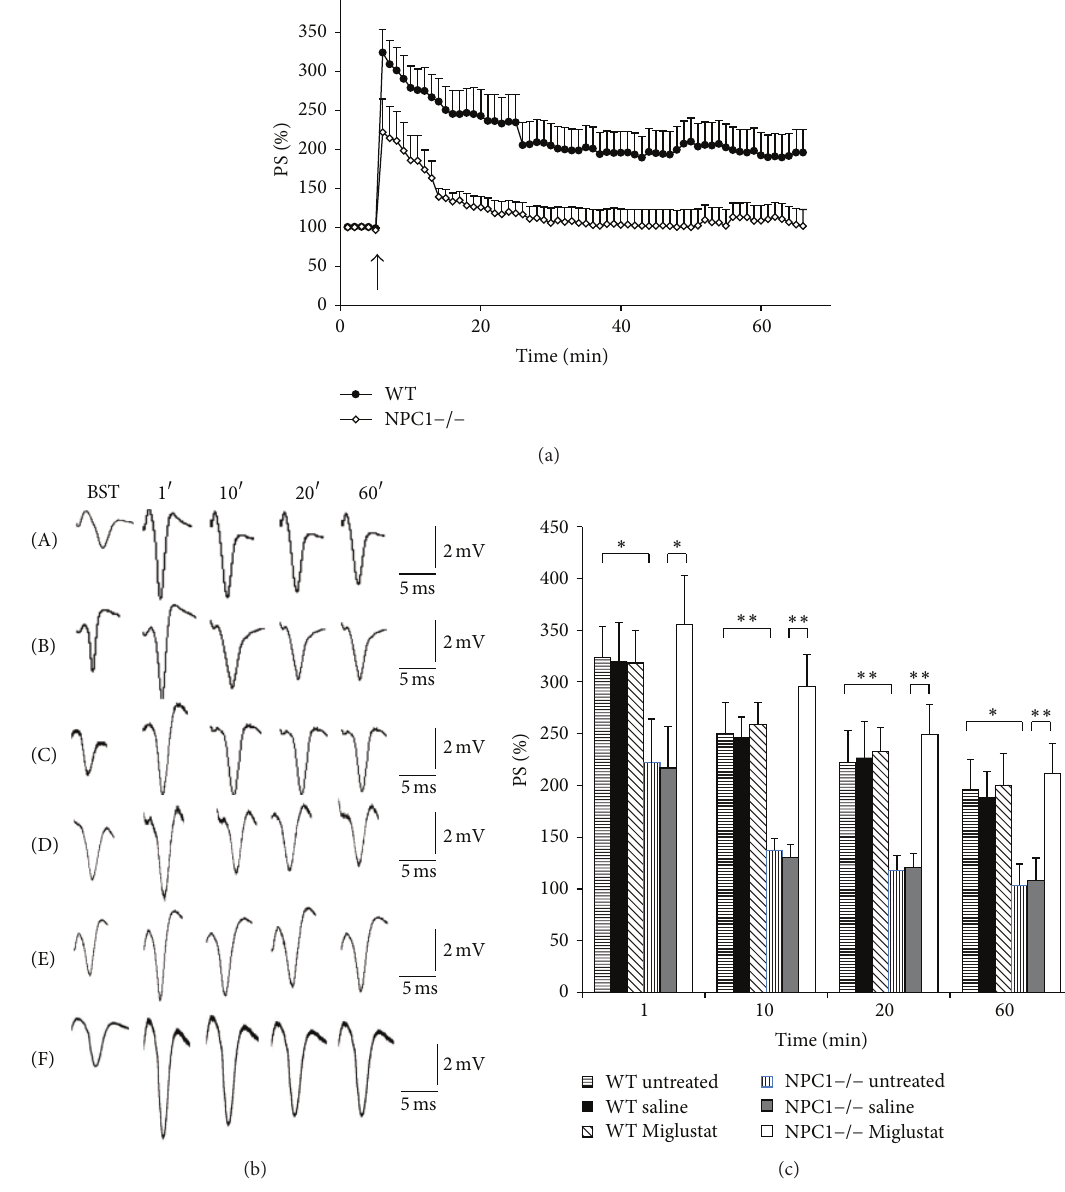
Figure 2: Synaptic plasticity in CA1 hippocampal subfield of WT and NPC1 − / − mice. (a) % PS amplitude as a function of time is shown after tetanic stimulation applied at time 𝑡 = 5 (arrow). The PS amplitude, measured every minute, corresponds to an average of 6 recordings/min. Points in the plot are means ± SEM of values obtained from different slices. Note the impairments of both the induction and the expression of LTP in NPC1 − / − untreated mice (white rombs, 𝑛 = 11 ) in comparison to the WT (black circles, 𝑛 = 12 ) untreated mice. (b) Recordings were obtained from different slices of WT (A) and NPC1 − / − untreated (B), WT saline (C) and NPC1 − / − saline treated (D), and WT Miglustat (E) and NPC1 − / − Miglustat (F) treated mice. The first curve of each group refers to the BST and it was recorded before the application of the tetanic stimulation, while the other curves refer to population spikes at times 1, 10, 20, and 60 min after the HFS. (c) % PS amplitude after HFS as a function of time is shown in WT untreated (horizontal pattern bar, 𝑛 = 12 ), in WT saline treated (black bar 𝑛 = 5 ), in WT Miglustat treated (diagonal pattern bar, 𝑛 = 5 ), in NPC1 − / − untreated (vertical pattern bar, 𝑛 = 11 ), in NPC1 − / − saline treated (grey bar, 𝑛 = 5 ), and in NPC1 − / − Miglustat treated (white bar, 𝑛 = 11 ) mice slices at minutes 1, 10, 20, and 60. Bars in the plot are means ± SEM of values obtained from different slices. Note significant statistical differences in PS amplitude during 1-hour recording in NPC1 − / − untreated versus WT untreated mice slices: PTP and LTP values at 10, 20, and 60min after tetanic stimulation were, respectively, 221.8 ± 42.5, 137.3 ± 11, 117.8 ± 14, and 103.3 ± 20.9 versus 323.8 ± 29.8, 250.2 ± 29.9, 222 ± 31.9, and 195.6 ± 29.8 ( ∗ 𝑝 < 0.05 at 1 and 60 min; ∗∗ 𝑝 < 0.01 at 10 and 20min). A statistically significant difference is also present in NPC1 − / − Miglustat treated versus NPC1 − / − saline treated mice slices: the values recorded were 355.7 ± 46.8, 295.8 ± 30.5, 249.4 ± 29, and 211.1 ± 29.1 versus 216.7 ± 40.4, 130.3 ± 12.4, 120.8 ± 13.5, and 108.3 ± 21.4 ( ∗ 𝑝 < 0.05 at 1min; ∗∗ 𝑝 < 0.01 for all the following